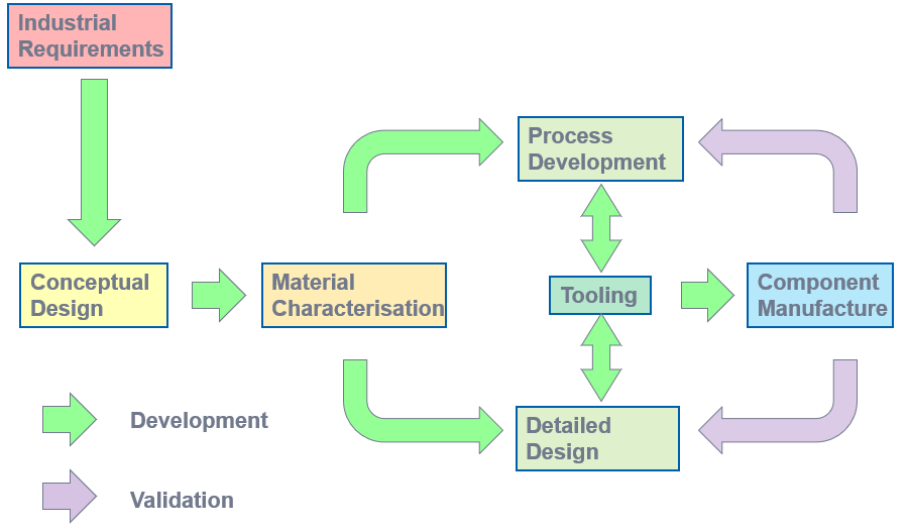
Figure 3. Composite-Product Development Process